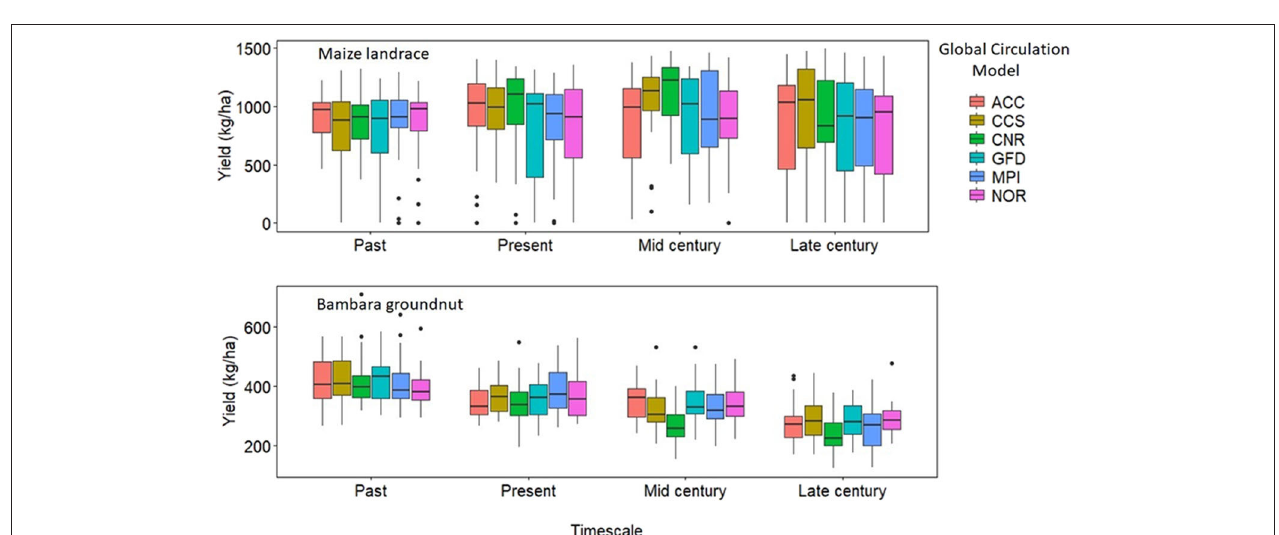
FIGURE 4 | Simulated yield (kg ha − 1 ) for maize landrace and bambara groundnut during four different timescales (Past, Present, Mid-, and Late-century) under rainfed conditions obtained from the six GCMs (ACC, CSS, CNR, GFD, NOR, and MPI). The effect of timescale on maize landrace grain yield - F -statistic: 3.492 on 3 DF, P = 0.01. The effect of the interaction between GCM and timescale on bambara groundnut grain yield - F -statistic: 1.953 on 15 DF, P = 0.01.